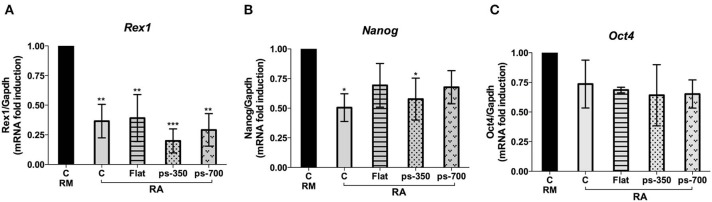
RA induces ES-Zscan4 cell differentiation. The ESZscan_Em cells were cultured for 72 h on control surfaces (CTR, RM and RA), Flat, ps-350, and ps-700 surfaces treated with RA. mRNA expression levels of pluripotency genes: Rex1 (A), Nanog (B), and Oct4 (C) were assessed by qPCR and normalized to RM condition. Error bars represent SD of triplicate samples from three independent biological replicates. Asterisks indicate significant differences with respect to the CTR-RM condition. Levels of significance are: ns > 0.05; *p <0.05.